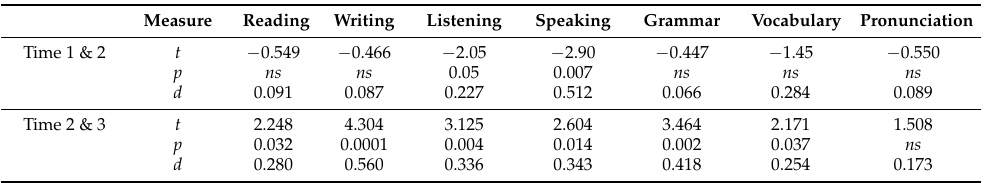
Table 4. Pairwise comparisons of self-reported proficiency in four skills and three domains of French between Time 1 and 2 and between Time 2 and 3 (paired t-tests with Cohen’s d).